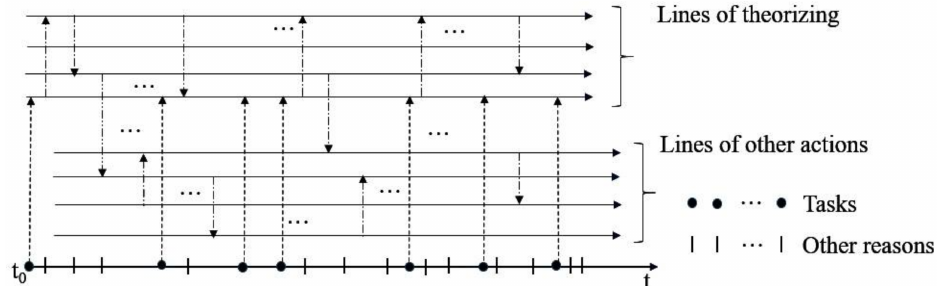
Figure 14. Switching among lines of